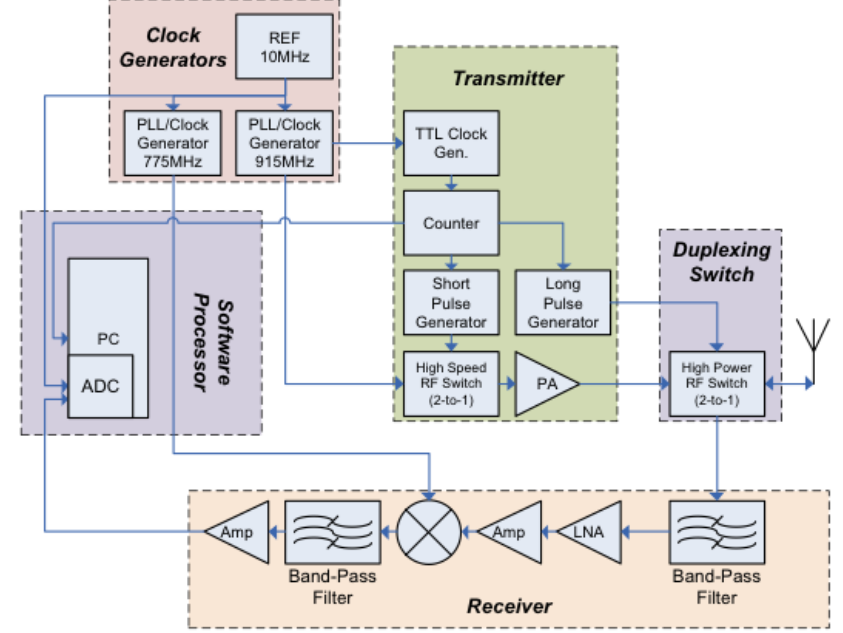
Figure 14. A simple block diagram of an implemented RF transceiver at 915 MHz.